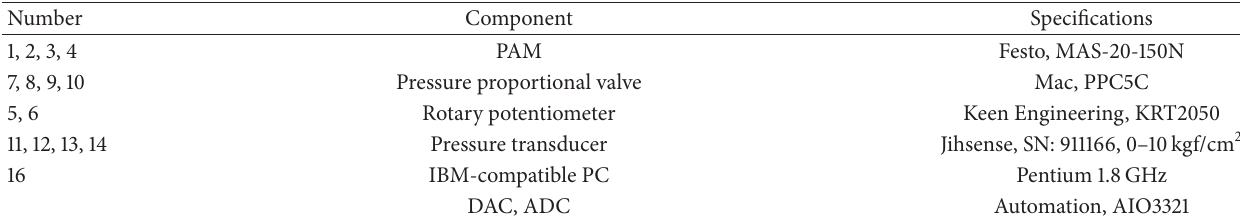
Table 1: Component